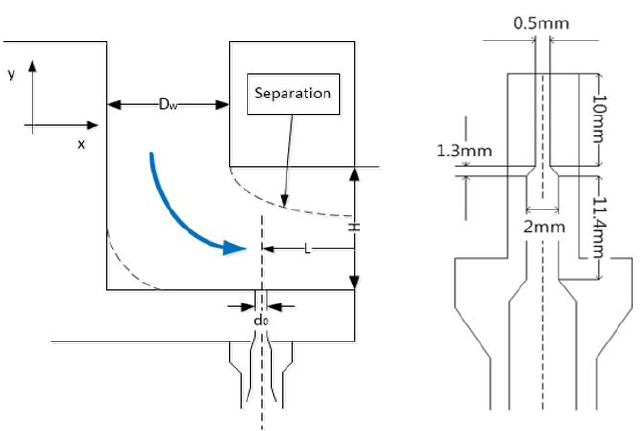
Figure 4. Cross-section schematics of the L-shape channel and the fuel